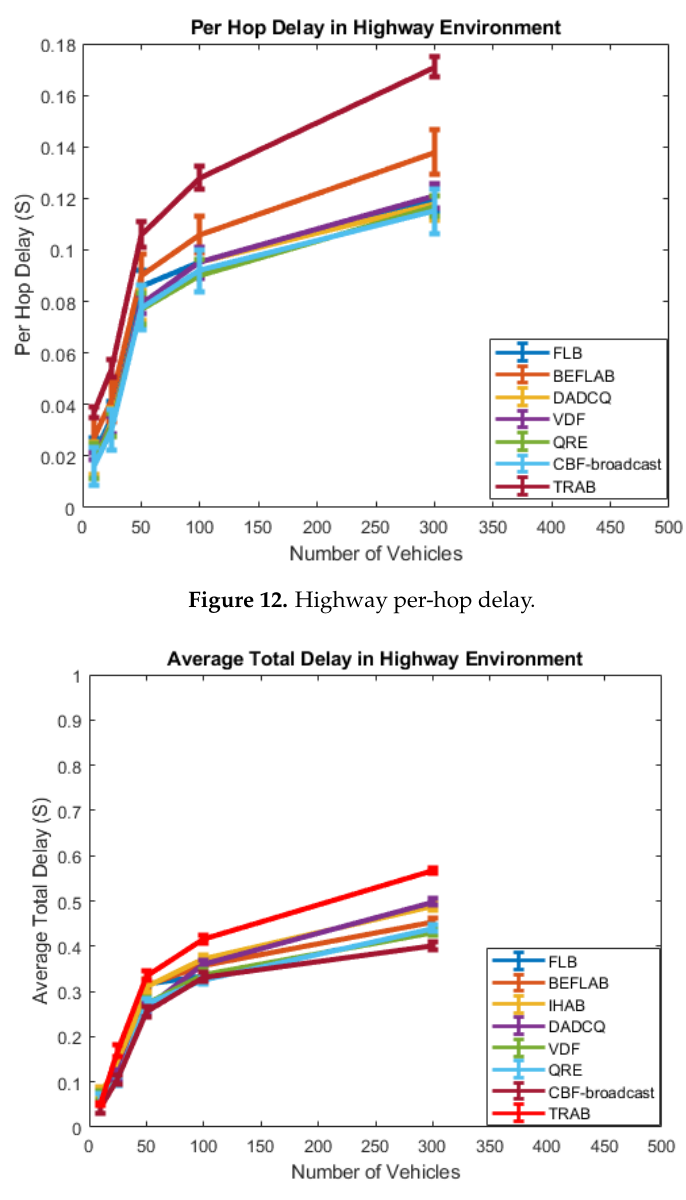
Figure 13. Highway average total